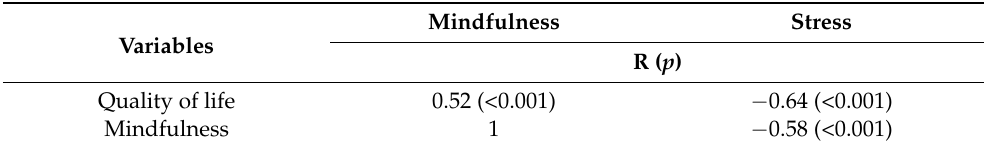
Table 3. Correlation among mindfulness, stress, and quality of life ( N =